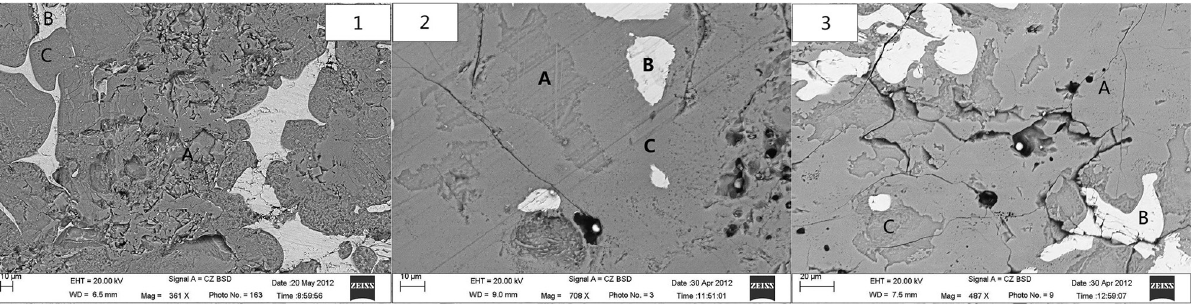
Fig. 2: Scanning electron microscope of sample No. 1, No. 2 and No. 3 (A – phosphorus-enrichment phase, B – metal oxide phase, C – matrix